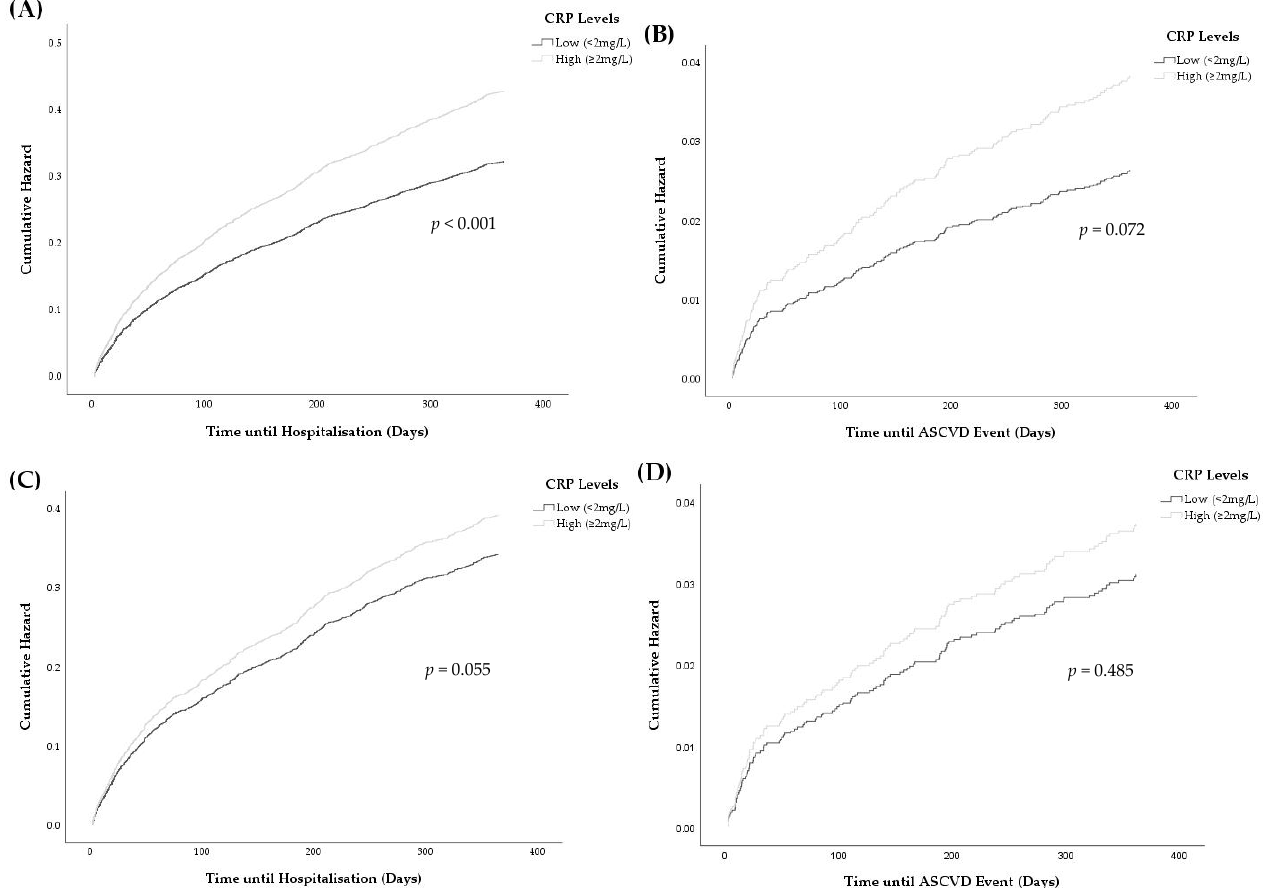
Figure 6. Cumulative risk of all-cause and ASCVD hospitalisations for low (grey) and high (black) CRP levels over the 12-month follow-up period. Model 1 involved adjustments for age and gender, and model 2 involved further adjustments for the independent determinants of CRP. ( A ) Risk of all-cause hospitalisations in model 1. ( B ) Risk of ASCVD hospitalisations in model 1. ( C ) Risk of all-cause hospitalisations in model 2. ( D ) Risk of ASCVD hospitalisations in model 2.